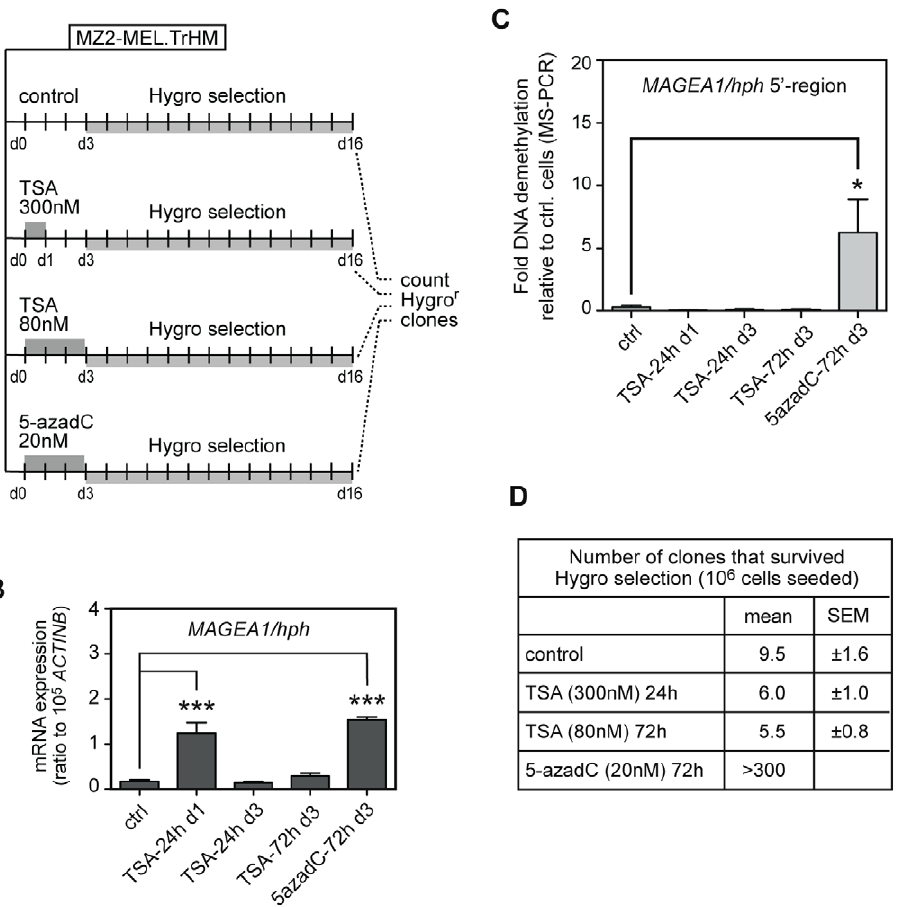
Figure 4. Lack of long-term activation of MAGEA1/hph following TSA treatment. A , Schematic outline of the experiment. MZ2-MEL.TrHM cells were treated or not (control) with 300 nM of TSA for 24h, 80 nM of TSA for 72h, or with 20 nM of 5-azadC for 72h. After three days, 10 6 cells from each group were transferred into two flasks (75 cm 2 ) and were selected in a medium containing hygromycin (180 m g/mL) during 13 days. B , The level of expression of the MAGEA1/hph transgene was quantified by qRT-PCR at the indicated time point (d1 or d3) in each group of cells. Data represent the mean ( 6 sem) of al least three independent experiments. *** P , 0.001. C , The level of DNA demethylation of the MAGEA1/hph 5 9 -region in the different groups of cells was evaluated by quantitative MS-PCR, using primers that specifically amplify the tagged transgene sequence. The data (fold DNA demethylation) were calculated as in Fig 2C, and correspond to the mean ( 6 sem) of at least three independent experiments. * P , 0.05. D , The number of clones that survived hygromycin selection were counted at day 16 in the three groups of cells. Data derive from at least two independent experiments, each in duplicate.